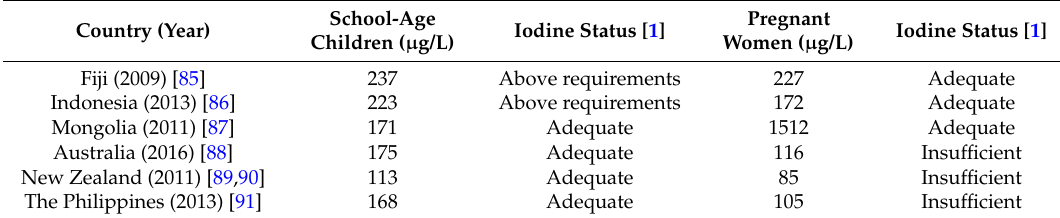
Table 5. Median urinary iodine concentration and iodine status of school-age children and pregnant women in selected countries in